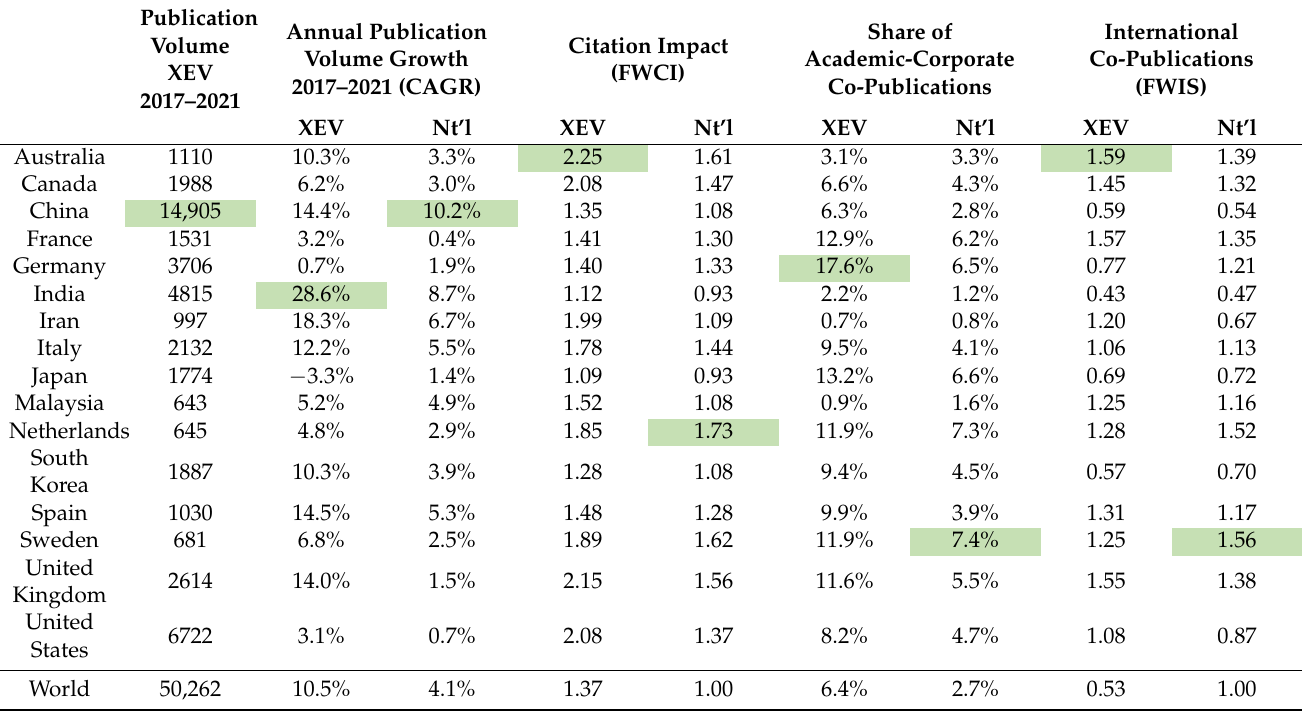
Table 1. Key indicators for XEV publications in